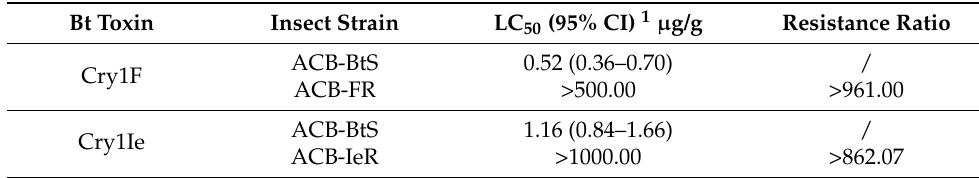
Table 1. The larvae lethal concentration (LC) and resistance ratio (RR) of ACB-IeR and ACB-FR strains compared with the susceptible ACB-BtS strains on Cry1Ie and Cry1F toxins. Bt Toxin Insect Strain